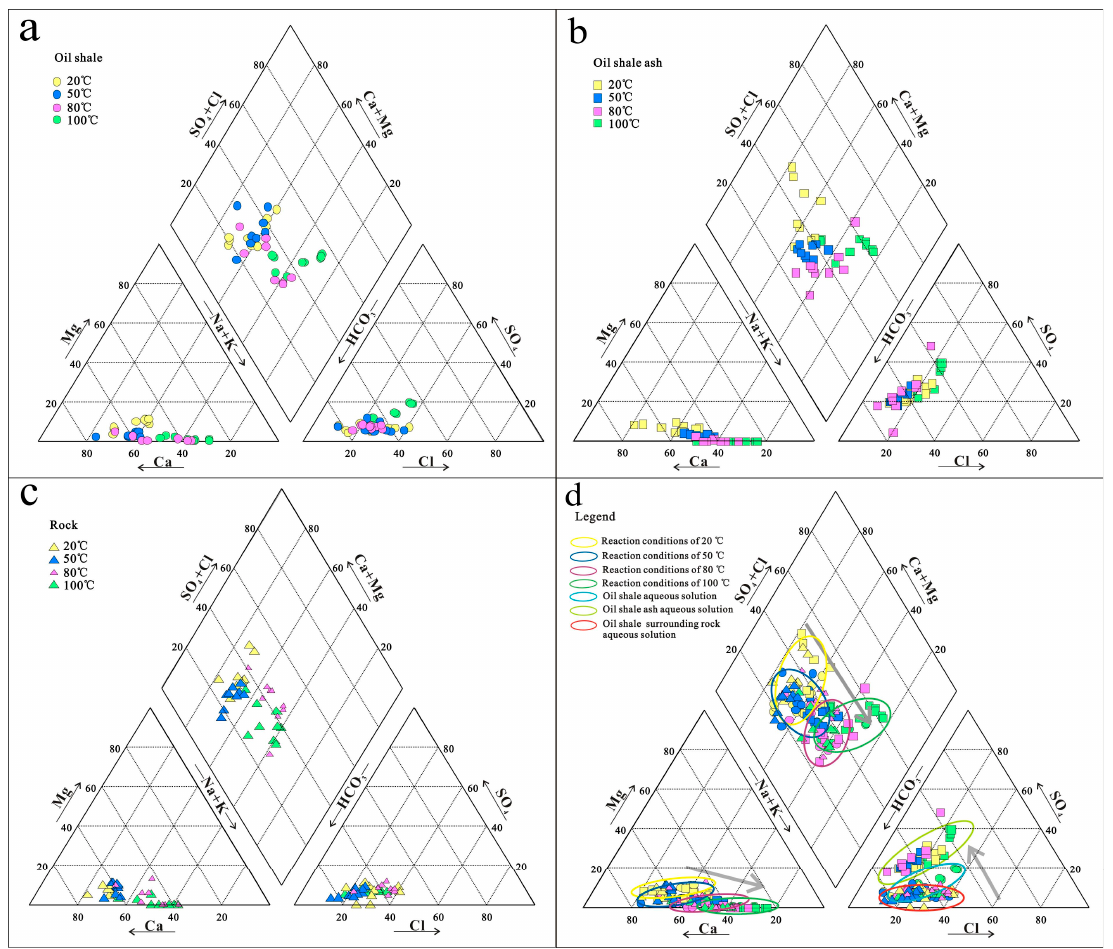
Figure 10. Piper ternary diagrams of water–rock interactions in the aqueous solution with different reaction conditions. ( a – c ) show the chemical compositions of water–rock interactions in oil shale aqueous solution, oil shale ash aqueous solution and rock aqueous solution, respectively. ( d ) shows the chemical compositions of these there aqueous solutions